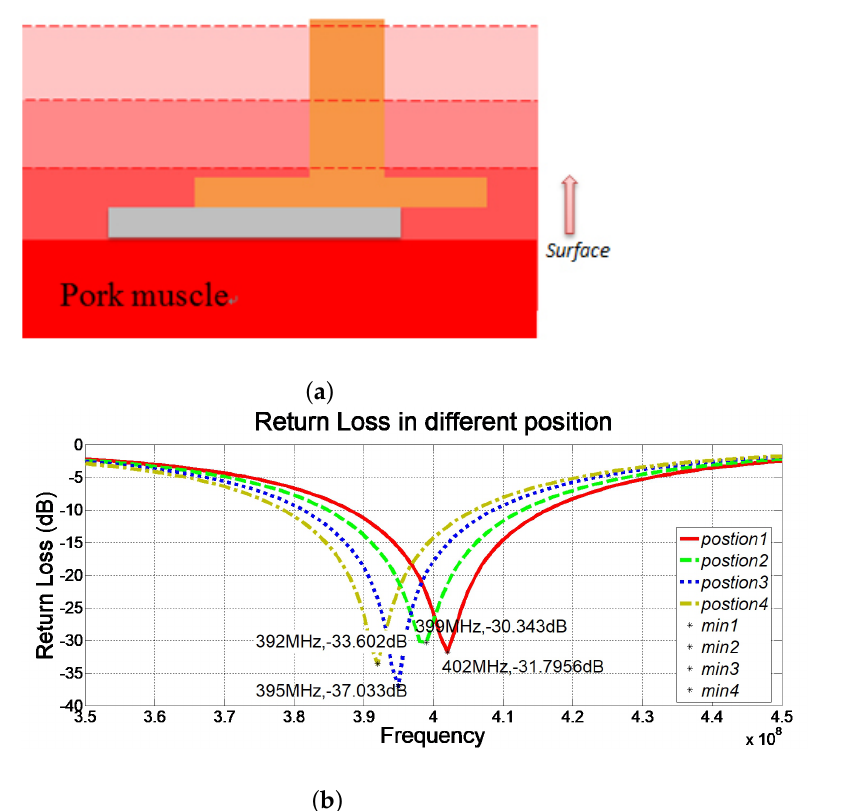
Figure 9. ( a ) Antenna embedded in different depths and ( b ) the corresponding return losses. A simple model of the SMA connector (shown in Figure 10a) was added to the original antenna design using the provided datasheet [21] to attest to the possible interference introduced by the connector. As expected, the resonant frequency deviated with a new value of 389 MHz (see Figure 10a), which is close to the measured result of 394 MHz. To further investigate the influence caused by the SMA connector, a variable h was set to a value ranging from 1 mm to 5 mm, and the analysis results are given in Figure 11. The resonant frequency declined (m1–m5) with the increase of the length (h). As a result, this investigation verified the influence of the SMA connector on the antenna. It proved the resonant frequency in the original model was accurate, and the design was effective.